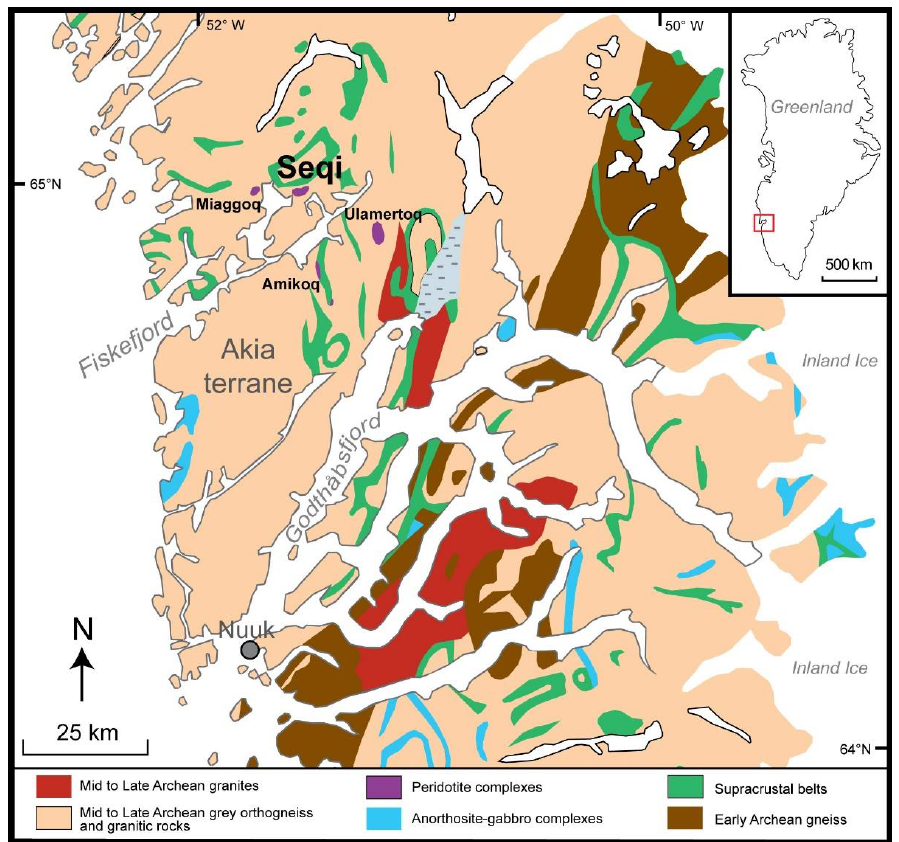
Figure 1. Geological map of the Nuuk region of SW Greenland consists of four main crustal terranes: Itsaq Gneiss Complex (3.8–3.6 Ga); Akia Terrane (ca. 3.2–3.0 Ga); Kapisilik Terrane (ca. 3.1–3.0 Ma); Tasiusarsuaq Terrane (2.92–2.84 Ga). The Seqi Olivine Mine is located at the end of Fiskefjord together with several similar Archean ultramafic bodies. Map modified after [9].